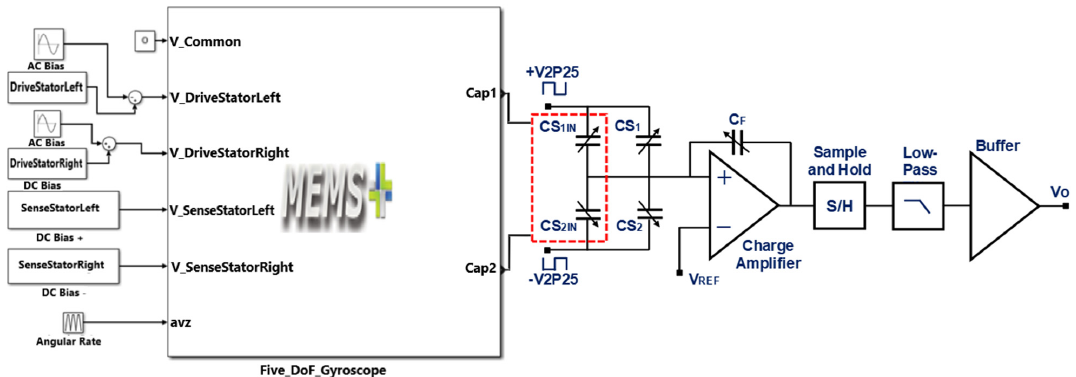
Figure 20. Integration of the MEMS gyroscope model with the readout electronics.